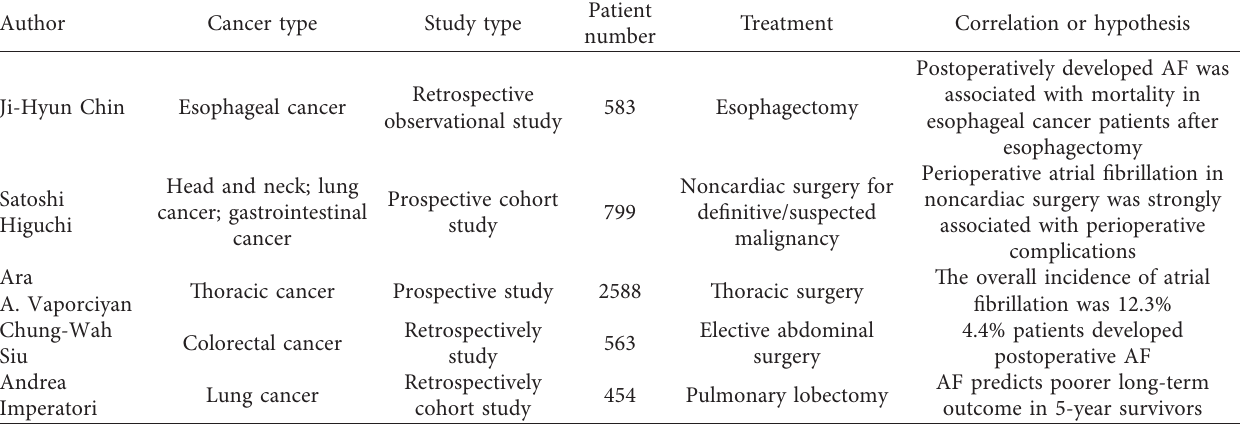
Table 1: Epidemiological evidence of AF in patients with